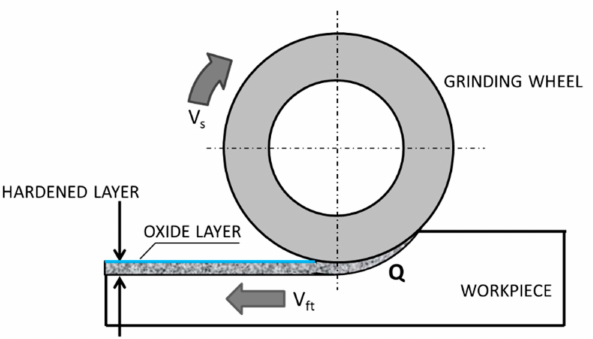
Figure 1. Grind-hardening process: v s —peripheral speed, v ft —feed rate, Q—heat rate entering the workpiece—based on references